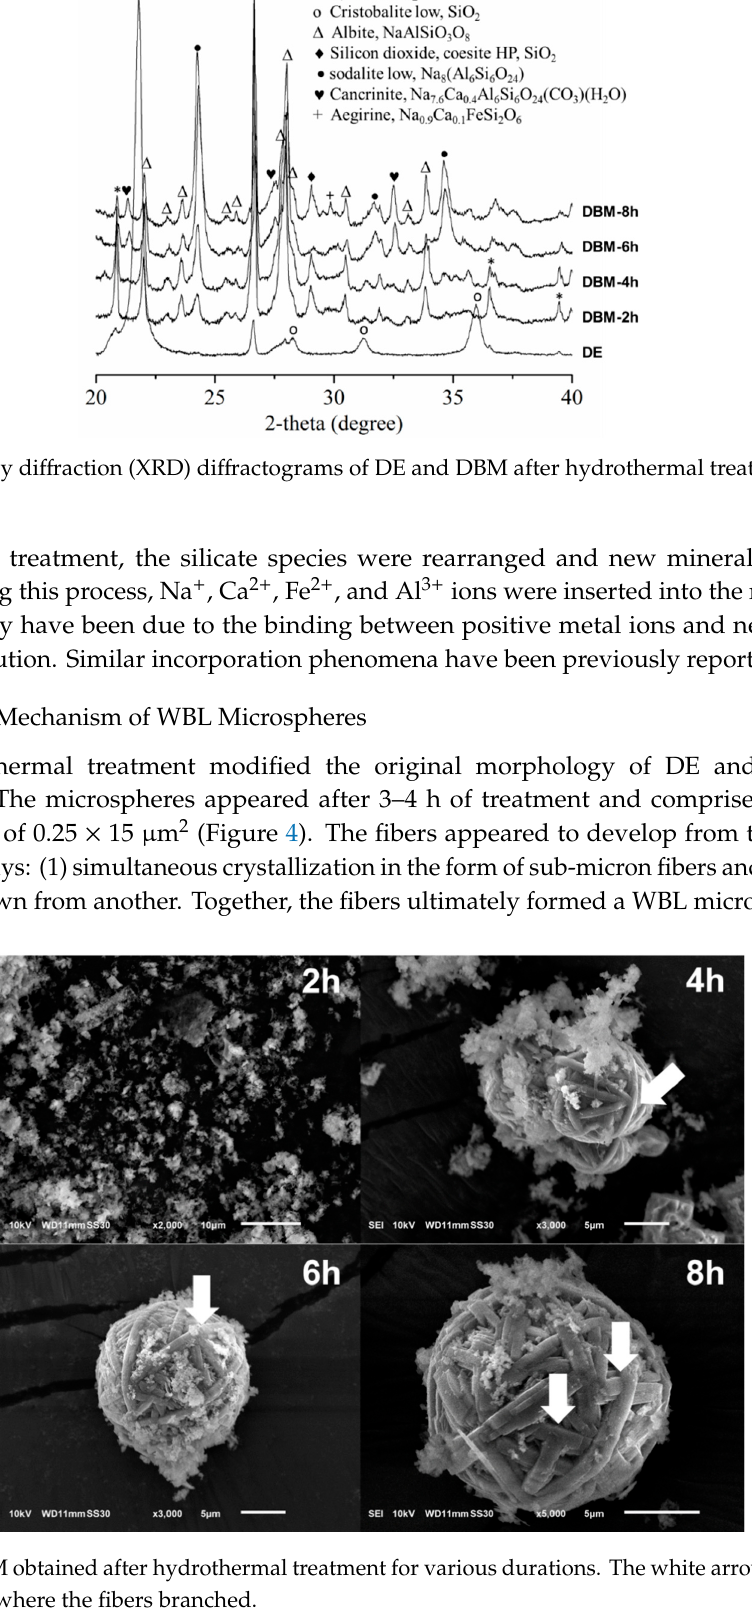
Figure 4. DBM obtained after hydrothermal treatment for various durations. The white arrows indicate the positions where the fibers branched.